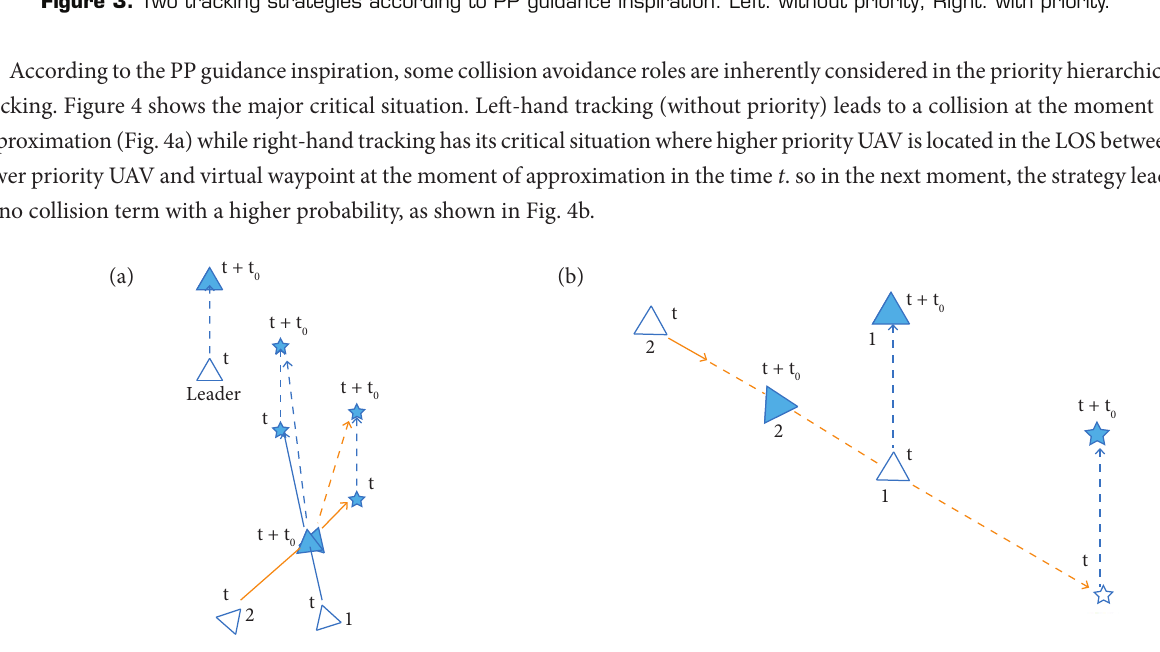
Figure 4. Tracking approaches at the moment of approximation a) without agent priority; and b) with agent priority. To derive the main equations, the state and control parameters should be defined according to problem requirements. The following nonlinear equations can express the plant model (Eqs. 3 to 5):